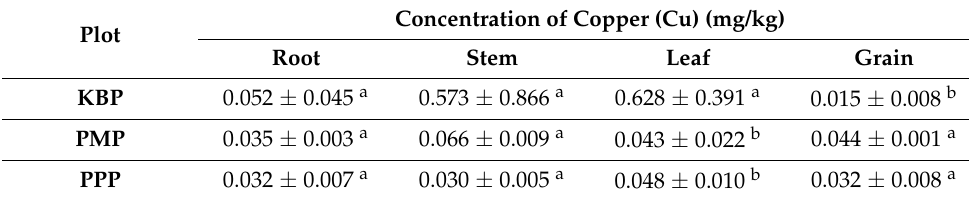
Table 6. Concentration of copper in different parts of paddy plants collected from Kelantan.